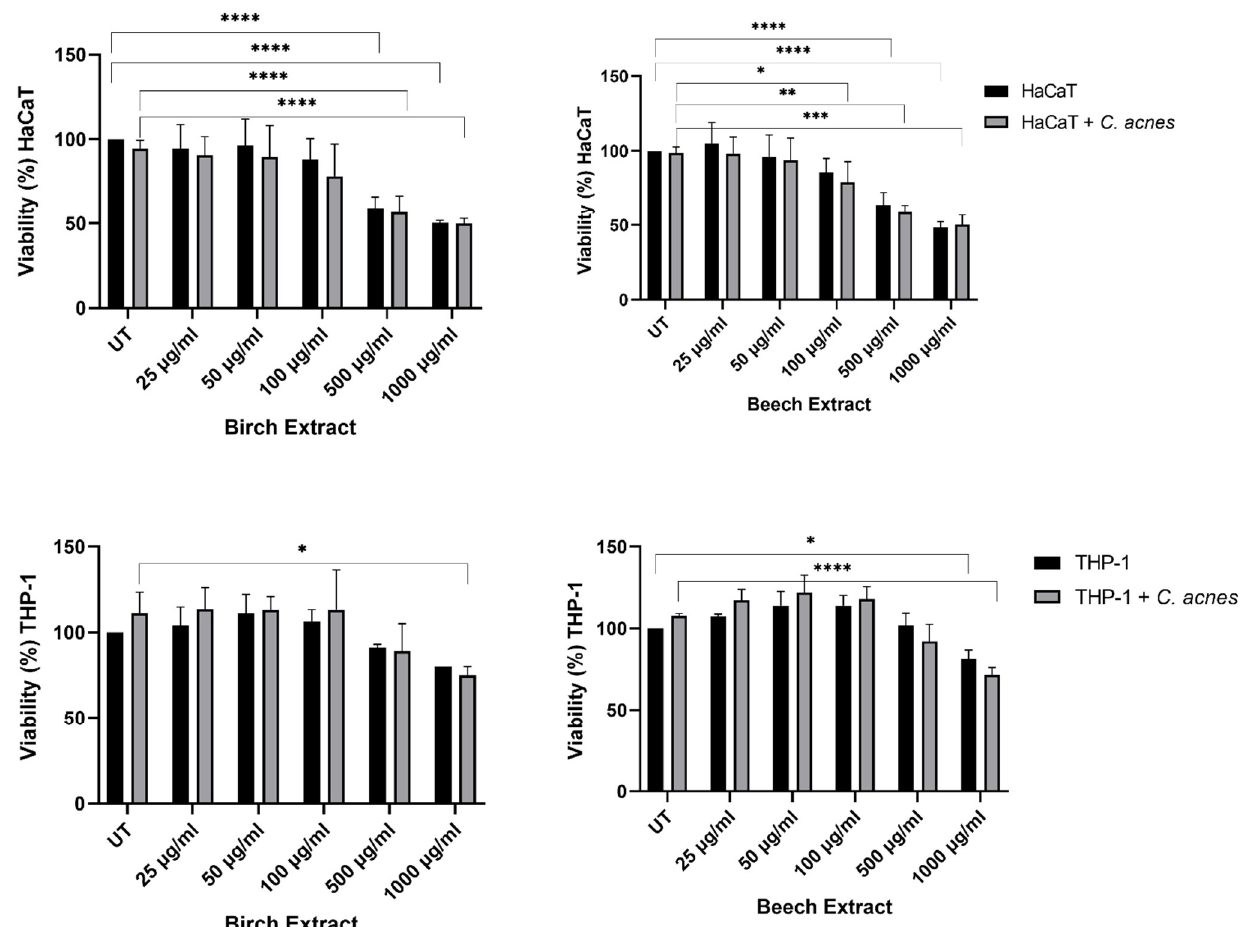
Figure 3. Viability test of HaCaT and THP-1 cell lines upon birch and beech extract treatment shown as percentage compared to the untreated control (UT). Experiments were performed in triplicates, n = 3, error bars on column depict SD. HaCaT unstimulated birch and beech: UT vs. 500 µ g/mL p **** and 1000 µ g/mL p ****; HaCaT stimulated birch: UT vs. 500 µ g/mL p *** and 1000 µg/mL p ****;